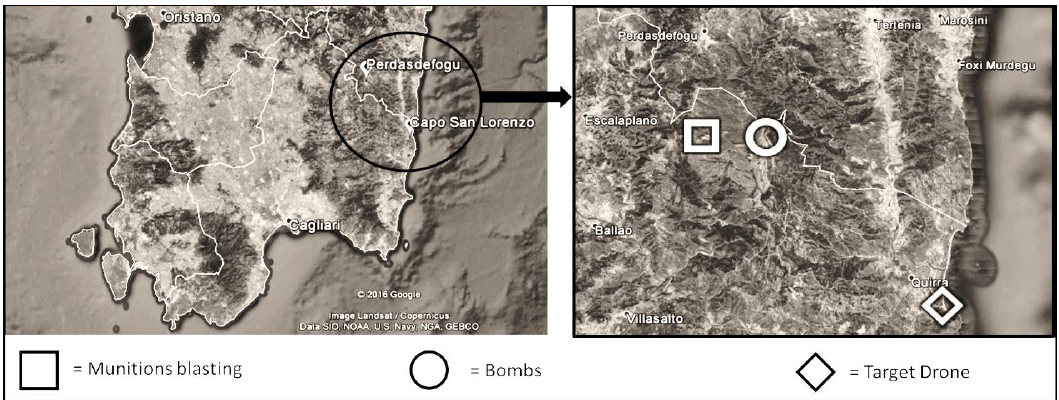
Figure 1. Geographical map of the Quirra Interforce Firing Range (QIFR); on the right, the approximate location of the military activities is described.